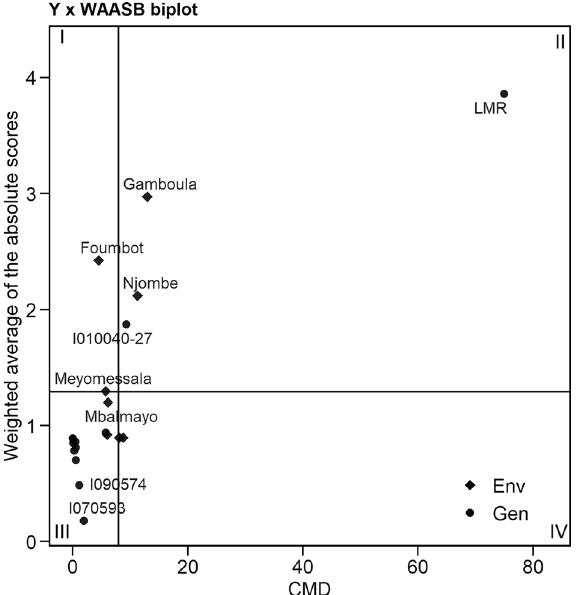
Figure 2. Genotype and genotype by environment interaction (GGE) biplot of the CMD Incidence versus a weighted average of absolute scores for the best linear unbiased predictions of the genotype versus environment interaction (WAASB) of 12 genotypes evaluated in eight environments (combination of 2 cultivation years). (R V3.6.2, https:// cran.r- proje ct. org/ web/ packa ges/